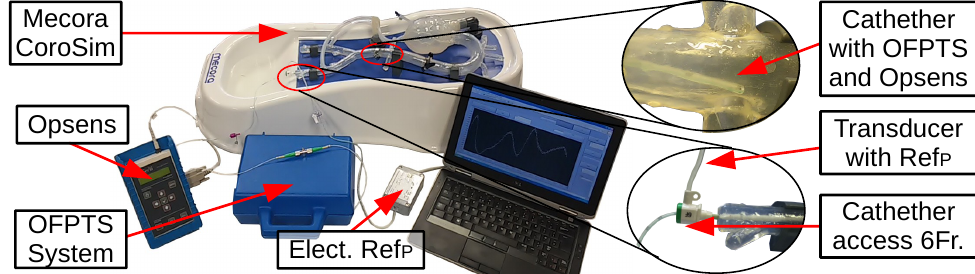
Figure 19. Mecoras CoroSim with Opsens and OMRON reference sensor.